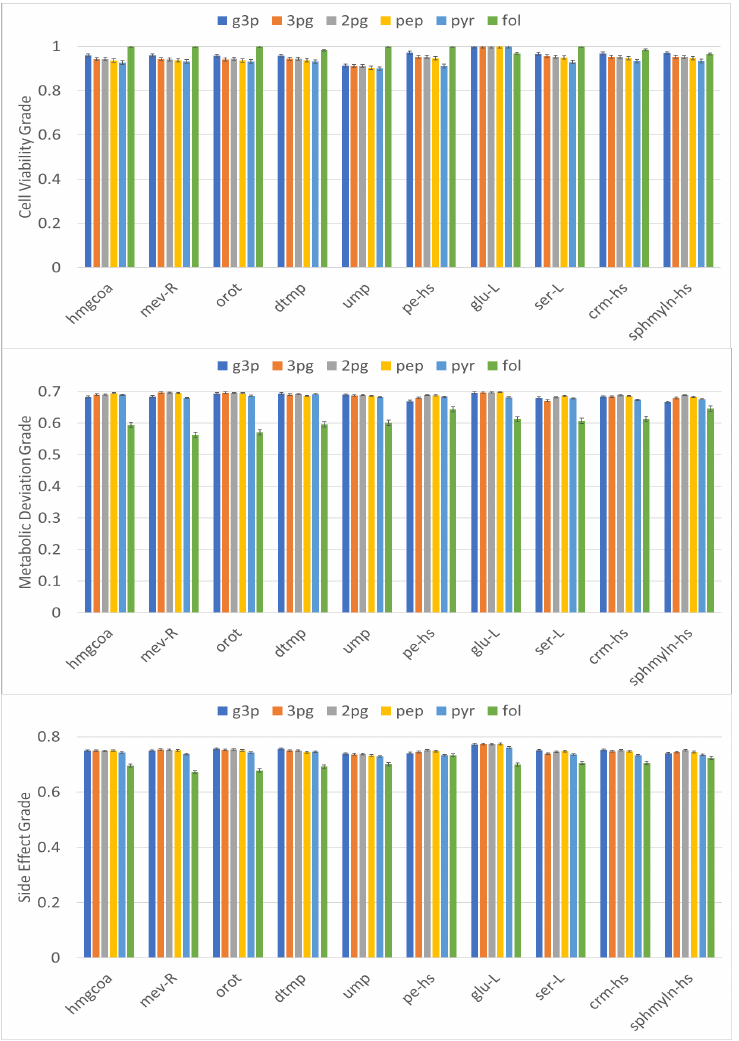
Figure 7. Membership grades for two-target combinations of antimetabolites. Membership grades of cell viability ( η CV ), metabolic deviation ( η DV ), and side effect ( η SE ) for two-target combinations of antimetabolites for colon cancer treatment. Cancer cell cytotoxicity was observed for each treatment. Inhibition of two-target antimetabolites (except folate enhancement) improved membership grades compared with one-target counterparts. Glutamate combined with the metabolites in the central carbon metabolism such as g3p, 3pg, 2pg, pep, and pyr had the highest grades. Error bar around each estimate was obtained through ten repeated